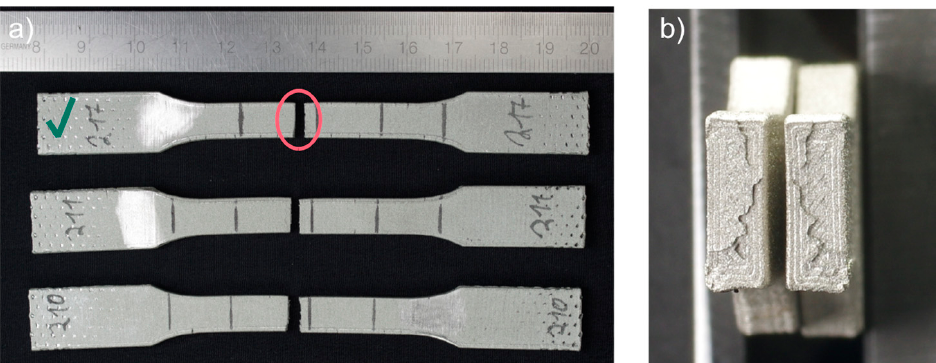
Figure 8. Fractures of tensile test BASF Ultrafuse 316L specimens presented as: ( a ) fractured speci- mens; ( b ) optical microscope image of the fracture surfaces, specimen 217. The samples have been numbered, which are visible in the figure. The letters L and R stand for the left-hand and right-hand sides of the sample in the figure. A green check mark means the specimen whose fracture faces were shown.